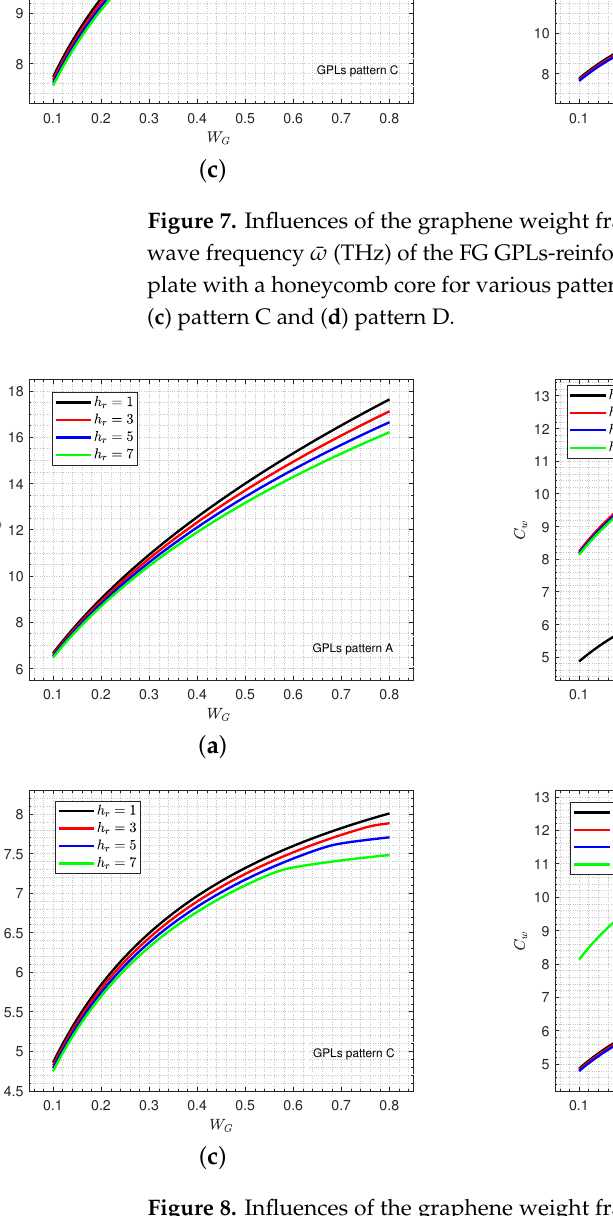
Figure 8. Influences of the graphene weight fraction W G and core-to-face thickness ratio h r on the phase velocity C w (km/s) of the FG GPLs-reinforced sandwich nanocomposite piezoelectromagnetic plate with a honeycomb core for various patterns of GPLs distribution: ( a ) pattern A, ( b ) pattern B, ( c ) pattern C and ( d ) pattern